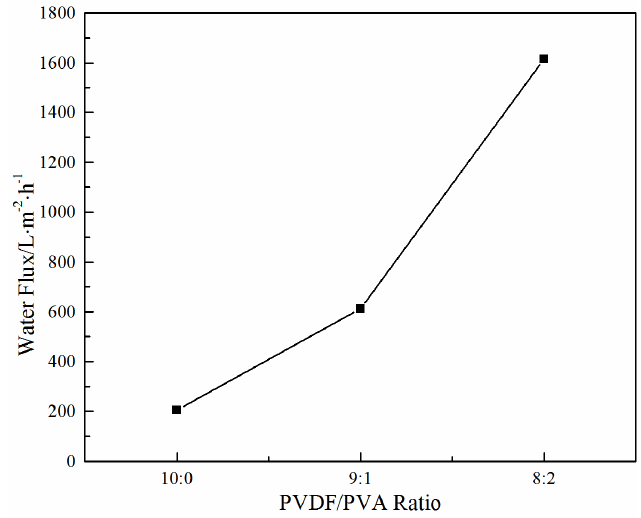
Figure 10. Effect of the PVDF/PVA blend ratio on water flux (total polymer concentration of 20 wt %).